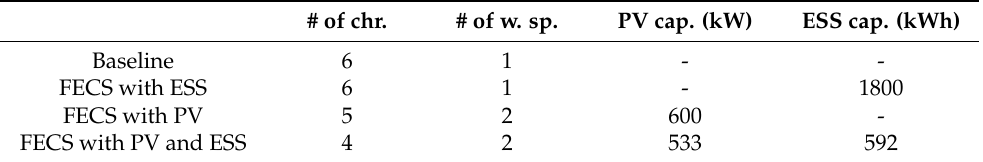
Table 3. Optimal FECS planning result, commute distribution. # of chr. # of w. sp. PV cap. (kW) ESS cap. (kWh) 6 1 -